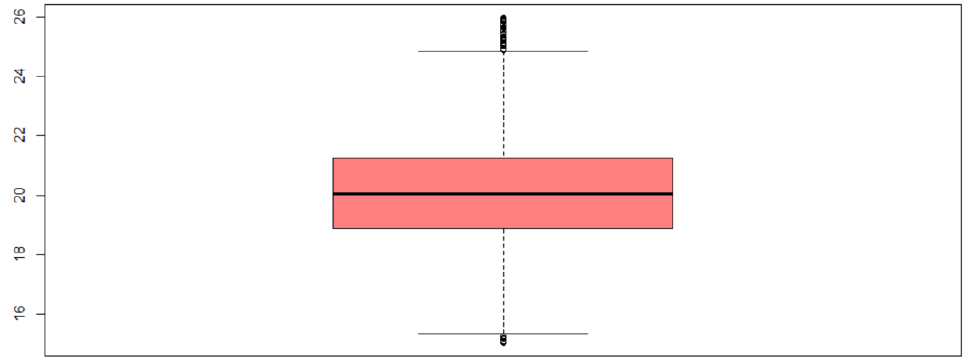
Figure 8. Box plot for humidity (%) globally (for all 26 time series). Humidity in (%): minimum 15.03, 1st quartile 18.86, median 20.04, mean 20.12, 3rd quartile 21.26, maximum 25.98.